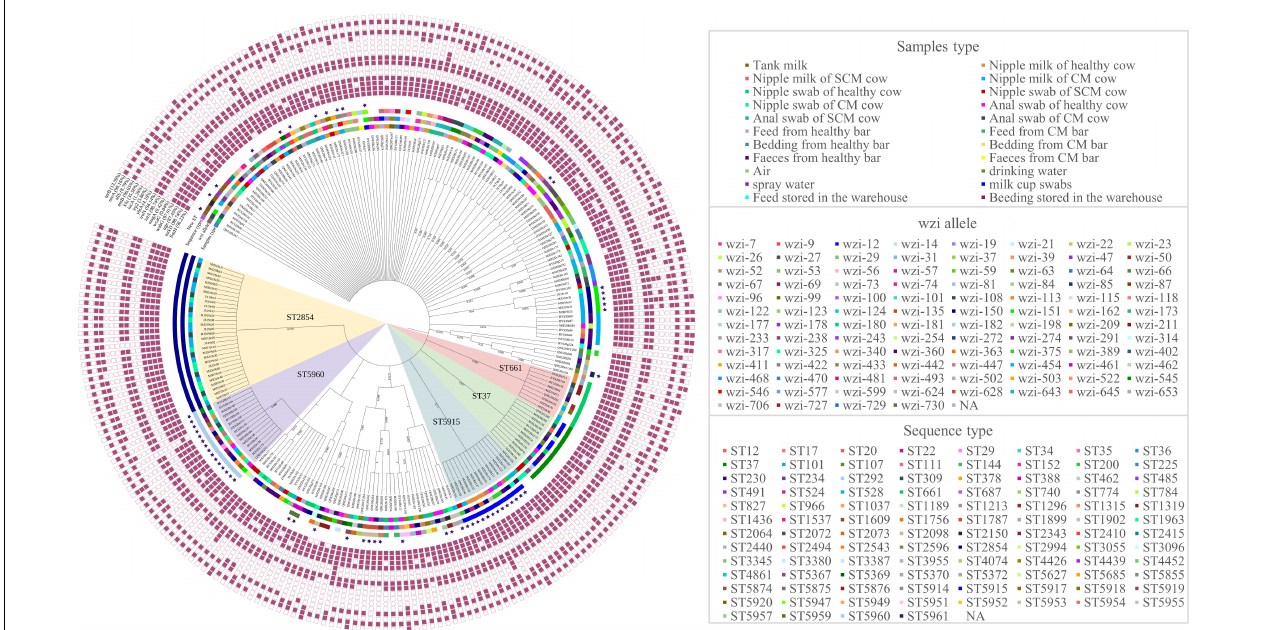
FIGURE 2 | Sequence type (ST) phylogenetic tree, wzi allele, and detection of virulence of 239 K. pneumoniae . The blue stars represent the new STs. PaleVioletRed squares represent the presence of virulence genes and white squares represent the absence of virulence genes, respectively. NA: No allele number